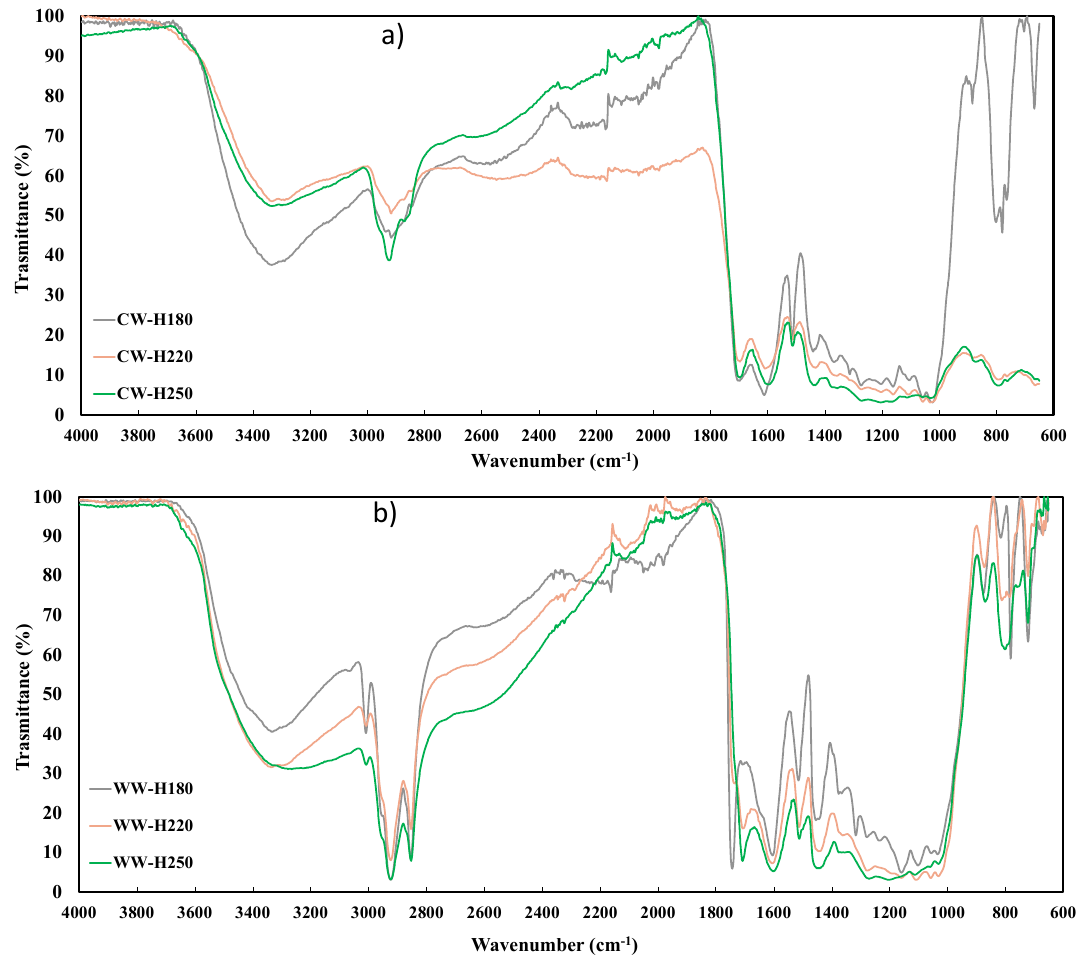
Figure 3. FTIR spectra of hydrochars produced from ( a ) citrus waste, ( b ) winery waste.